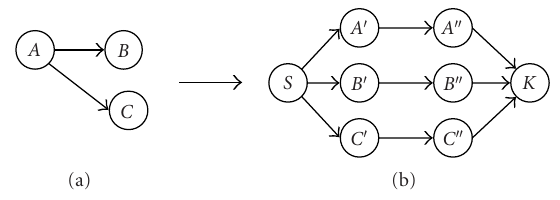
Figure 5: (a) An example instance of graph coloring problem, and (b) the mapped graph for the proof of Theorem 1.